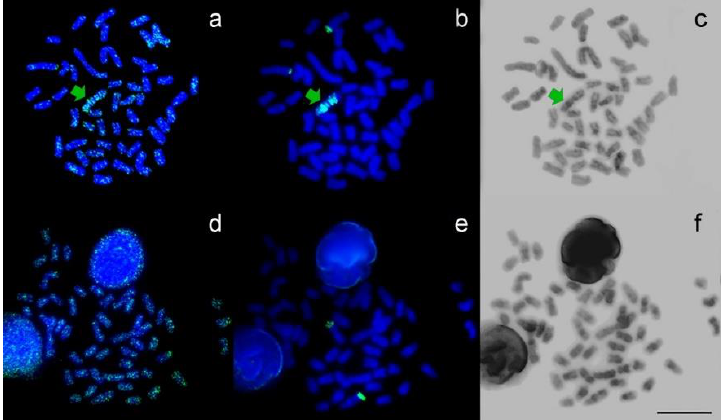
Figure 1. Metaphases of B+ ( a – c ) and B− ( d – f ) Astyanax scabripinnis sequentially treated with anti- 5-mC ( a , d ), FISH with an As 51 probe ( b , e ), and localization of heterochromatin regions using the C-banding technique ( c , f ). The B chromosome is indicated by green arrow It is possible to observe an evident marking in the telomeric region of another chromosomal pair, both in the B+ and B − genomes, strongly marked by As 51 probes ( b , e ). One of the pairs of complement A is probably related to the origin of the B chromosome of A . scabripinnis . Bar = 10 µ